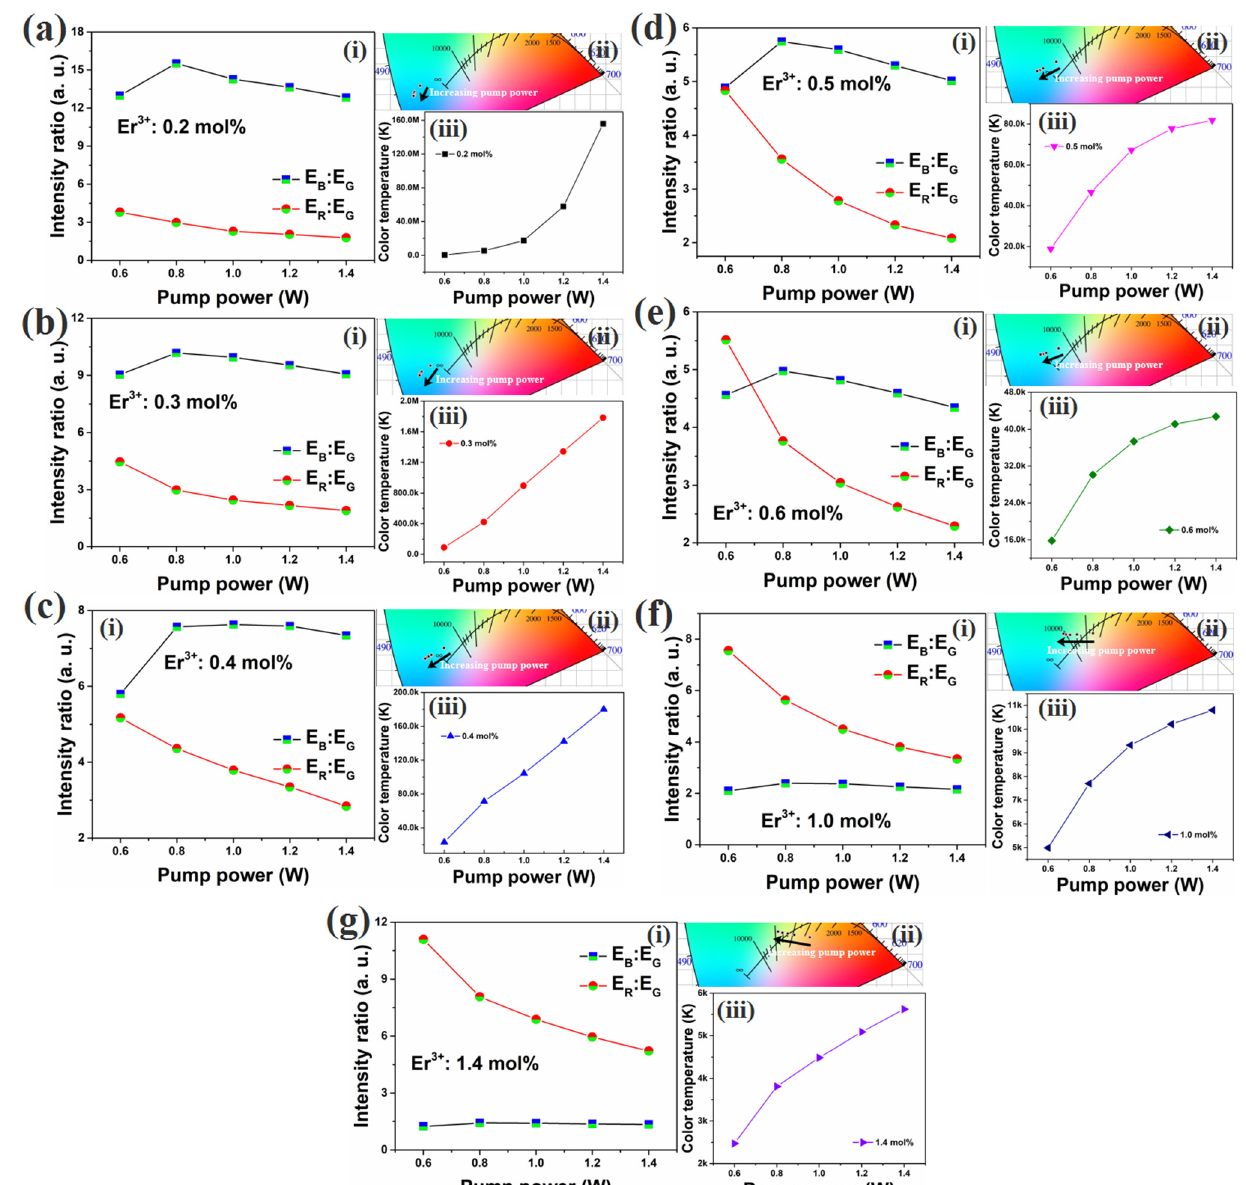
Figure 6. The intensity ratios of blue emission to green emission and red emission to green emission (i), CIE chromaticity coordinates (ii) and CCT for Y 2 O 3 -ZnO:Yb 3+ /Er 3+ /Tm 3+ -tridoped nano-phosphors (iii) for Y 2 O 3 -ZnO: Yb 3+ /Er 3+ /Tm 3+ nano-phosphors under 980 nm diode laser excitation with different pump powers (0.6, 0.8, 1.0, 1.2, and 1.4 W); ( a ) Er 3+ : 0.2 mol%, ( b ) Er 3+ : 0.3 mol%, ( c ) Er 3+ : 0.4 mol%, ( d ) Er 3+ : 0.5 mol%, ( e ) Er 3+ : 0.6 mol%, ( f ) Er 3+ : 1.0 mol%, and ( g ) Er 3+ : 1.4